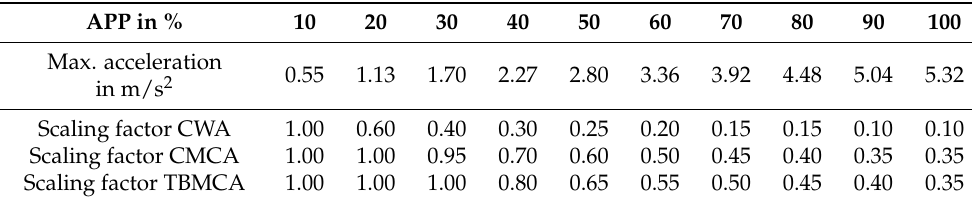
Table 2. Scaling factors (calculated in steps of 0.05) of all three MCAs at different APPs. APP in %